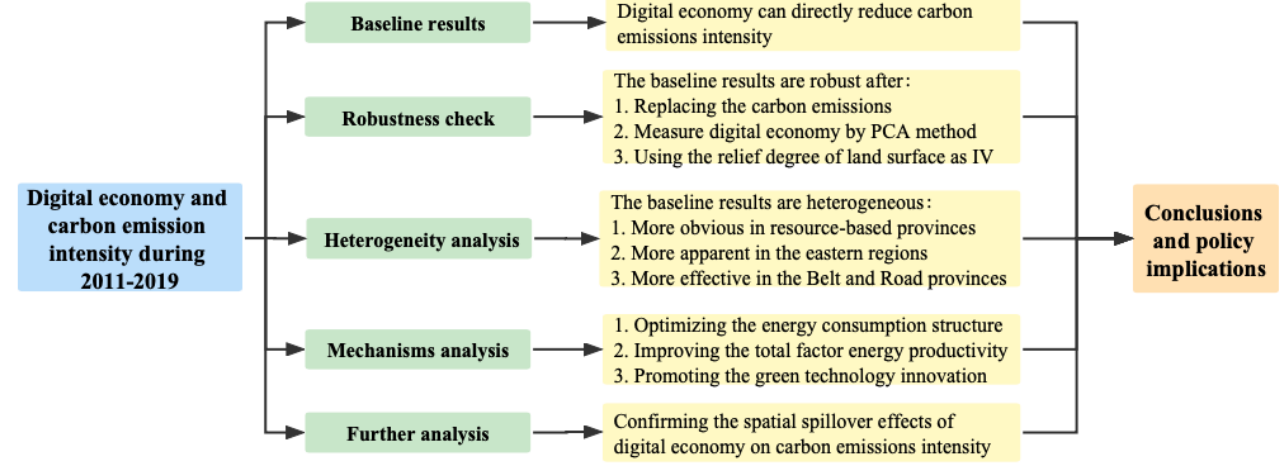
Figure 2. The main findings of the effect of digital economy on carbon emission intensity.